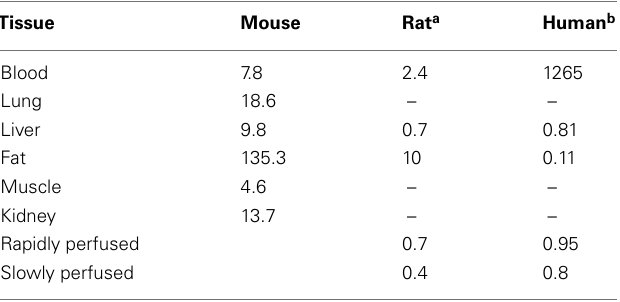
Table 3 |Tissue-to-air partition and tissue-to-blood coefficients used in the three PBPK models.